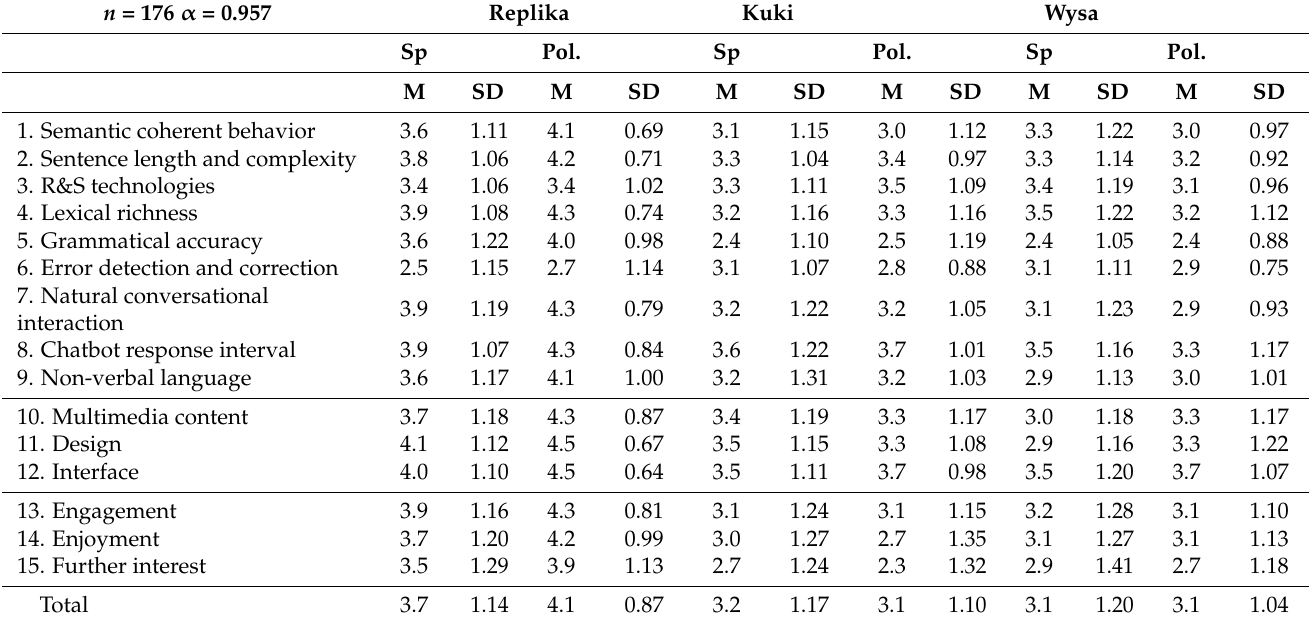
Table 5. Results of the Chatbot–Human Interaction Satisfaction Model (CHISM). Five-point scale (1 = not satisfied at all to 5 = completely